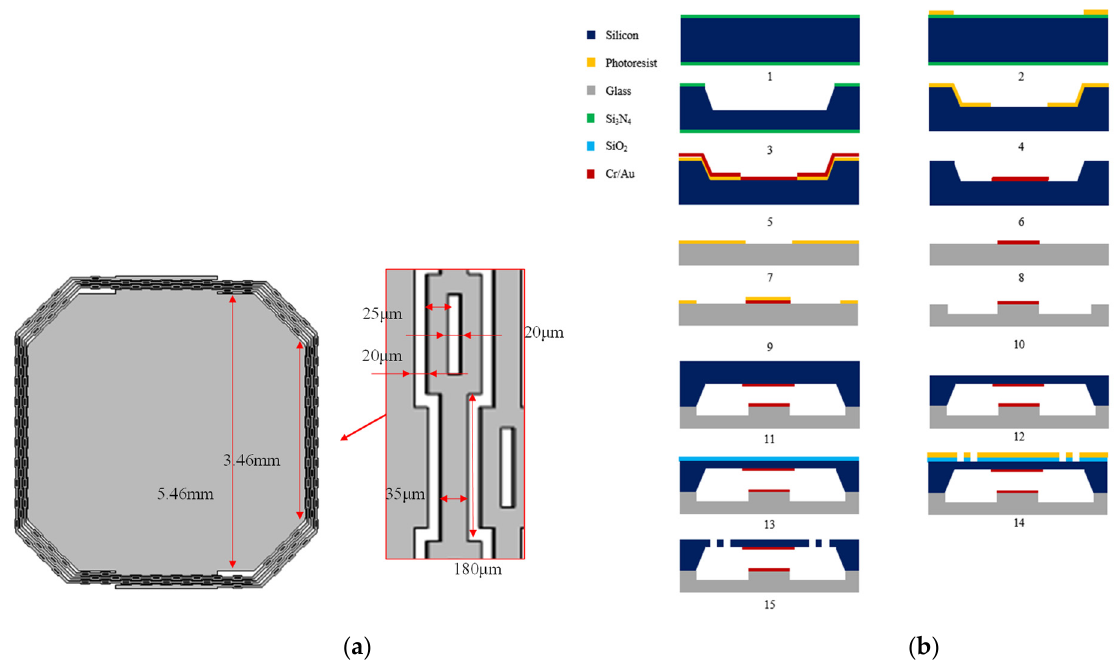
Figure 10. ( a ) Detailed size of the fabricated device; ( b ) Fabrication process of the